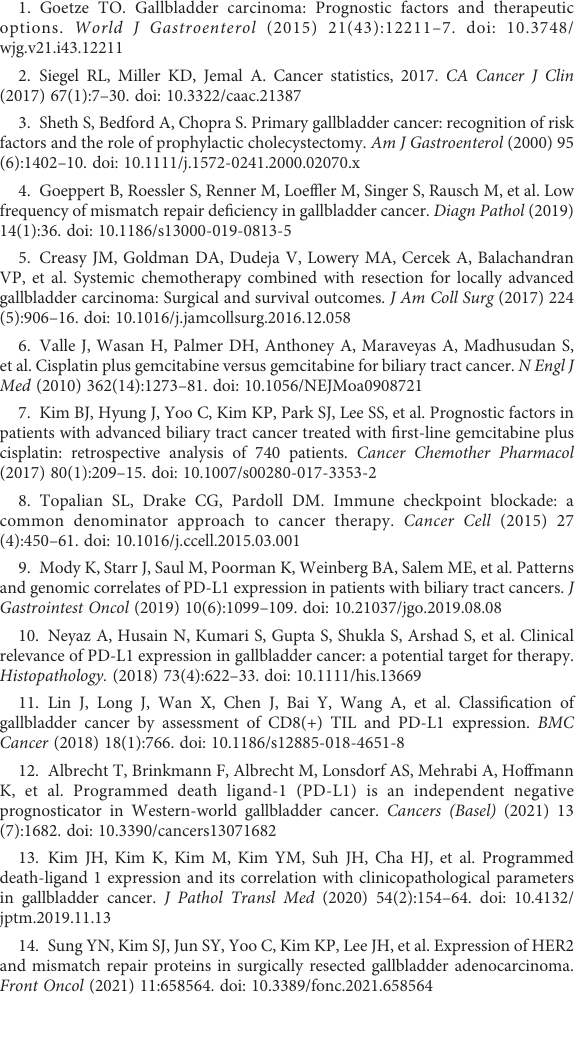
SUPPLEMENTARY FIGURE 1 Kaplan − Meier survival curves presenting the associations of B7-H3, B7- H4, and HHLA2 expression, as well as the density of CD8+ TILs, with overall survival (OS) and cancer-related survival (CRS). (A) The associations of each parameter with OS in the training group; (B) The associations of each parameter with CRS in the training group; (C) The associations of each parameter with OS in the testing group; (D) The associations of each parameter with CRS in the testing group. SUPPLEMENTARY FIGURE 2 Kaplan − Meier survival curves present immune strati fi cation ’ s association with OS and CRS.